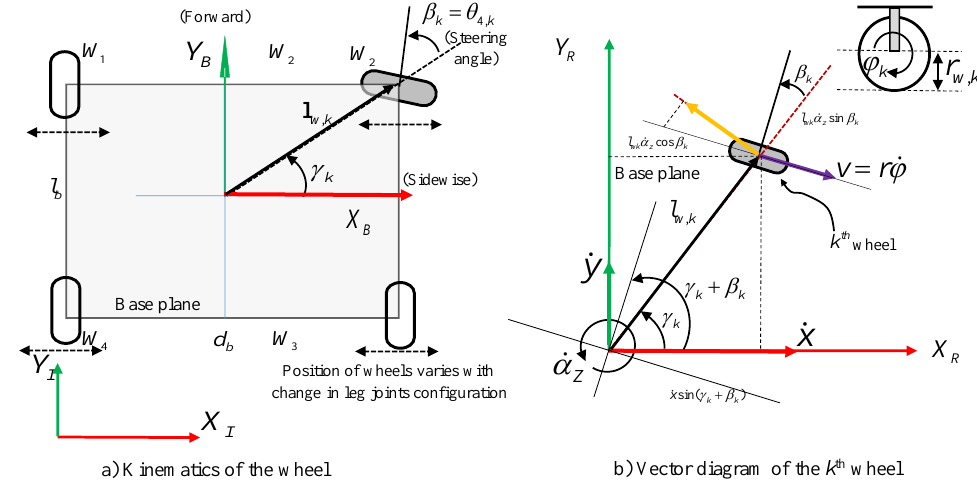
Figure 10. Steering kinematics of the wheels with varying base